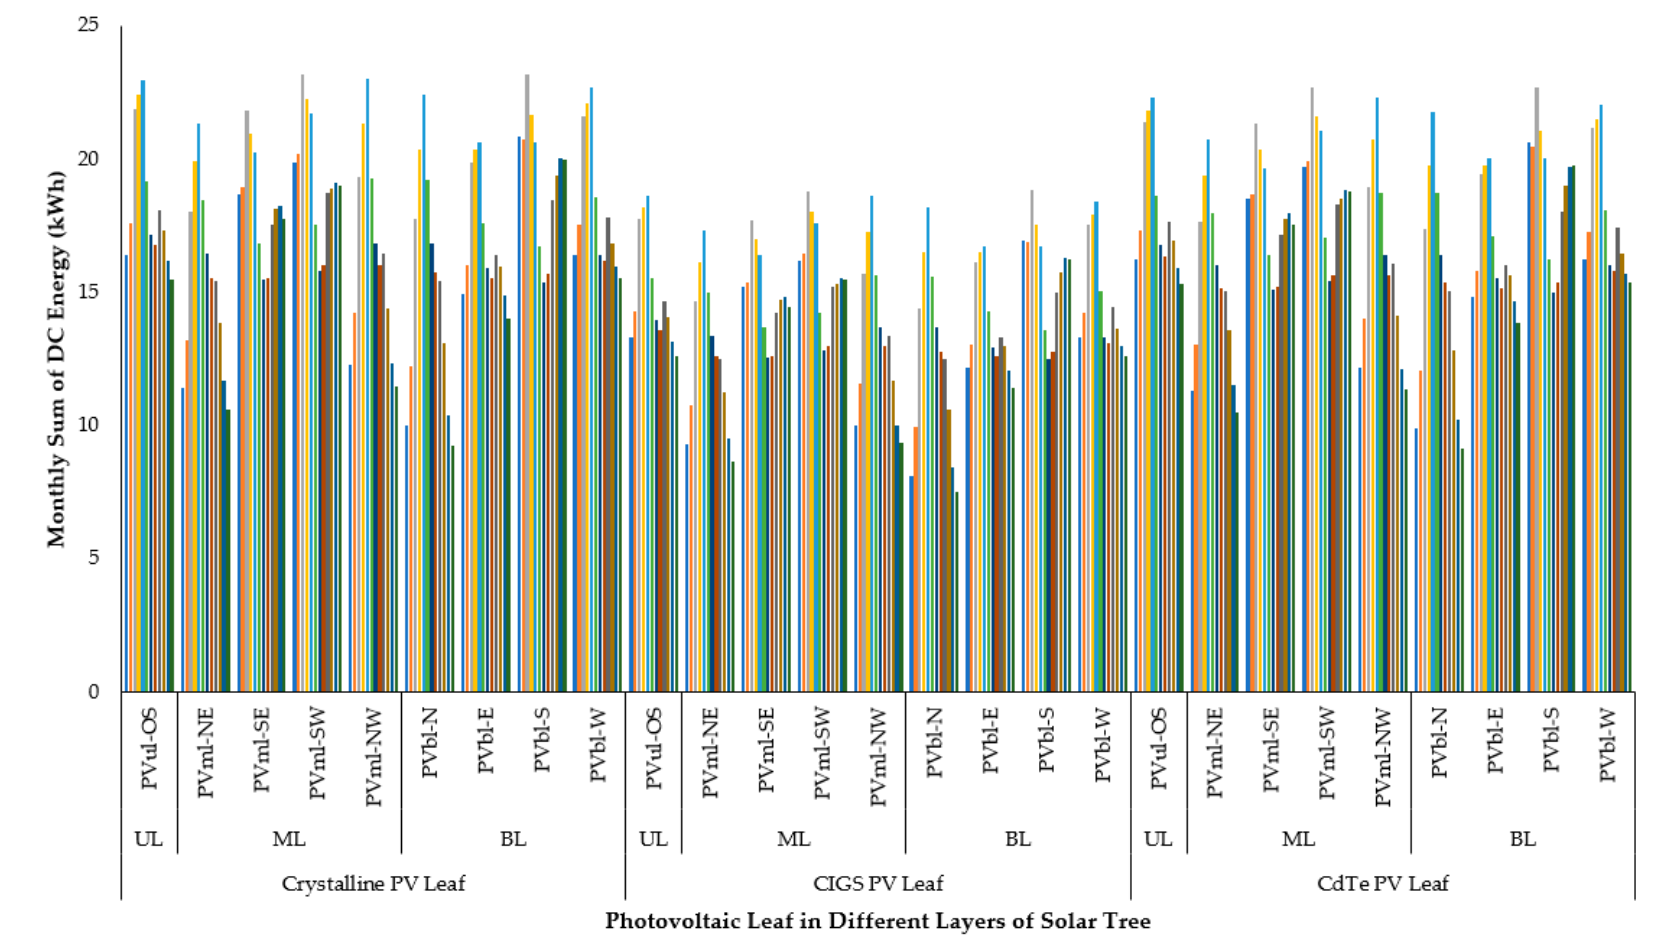
Figure 8. Comparison of monthly energy outputs of a solar photovoltaic tree in three different layers for the three different c-Si, CIGS, and CdTe solar cell technologies.